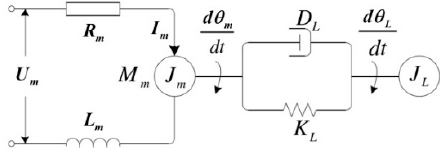
Figure 6. Simulation modules of the System’s General Kinematics and Compensations.